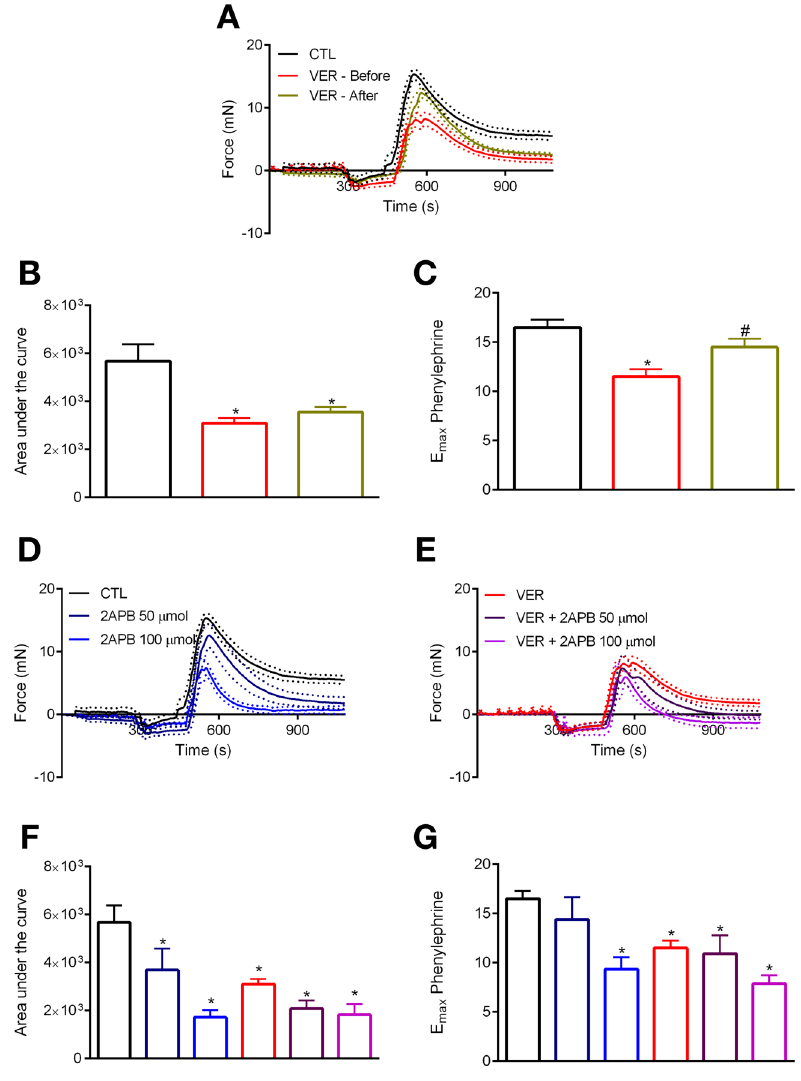
Figure 2. HSP70 contributes to phenylephrine-induced phasic contraction via IP3r-mediated intracellular Ca 2 + release. Aortic rings were challenged with phenylephrine ( 10 µ mol/l ) in 0[ Ca 2 + ] Krebs’ solution in the presence of vehicle (CTL) or VER155008 ( 10 µ mol/l , DMSO diluted), which was added before or after IP3r- 2 + mediated Ca release ( A ). In another set of experiments, samples were stimulated in the presence of ( D ) 2-aminoethoxydiphenyl borate (2-APB) (50 and 100 µ mol/l , DMSO diluted), or ( E ) the combination of 2-APB 2 + and VER155008. Inhibitors were added before IP3r-mediated Ca release. ( B , F ) Area under the curve and ( C , G ) E max . Panels ( B , C ) and ( F , G ) use the same color scheme as panels ( A ) and ( D , E ), respectively. Data are expressed as mean ± SEM. n = 14 for CTL and VER—before, n = 9 for VER—after, and n = 6 for all other groups, * p < 0.05 vs. CTL and # p < 0.05 vs.